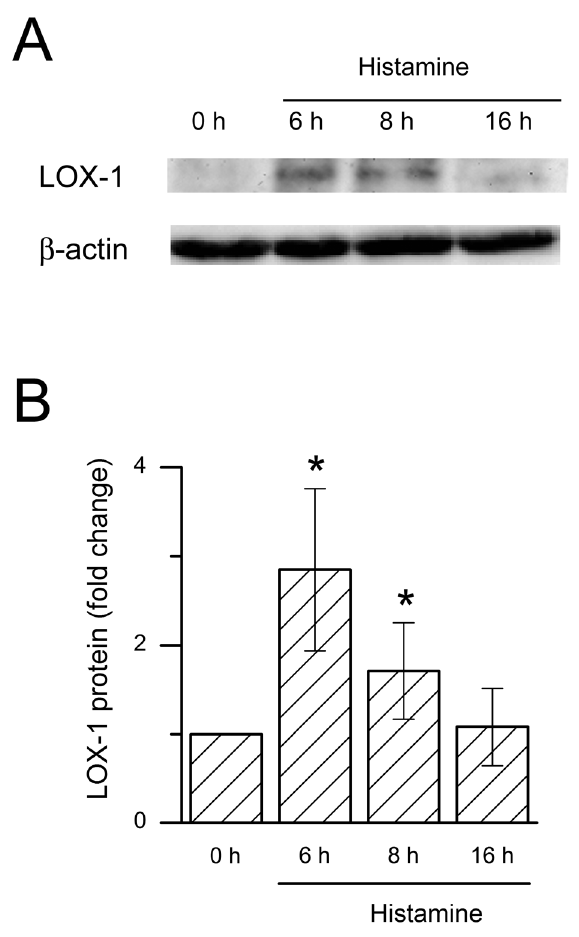
Figure 3. Time-dependent expression of LOX-1 protein in histamine-treated human macrophages. A) Monocyte-derived macrophages were cultured in the presence of 10 m M histamine for 6, 8, and 16 h. The cells were then lysed and LOX-1 protein expression was analyzed by Western blot technique. B) LOX-1 protein levels were quantified, normalized to b-actin, and compared to the levels at the beginning of the incubation (controls). The results are presented as means 6 SEM (n=4 donors). *p , 0.05 vs. control cells.